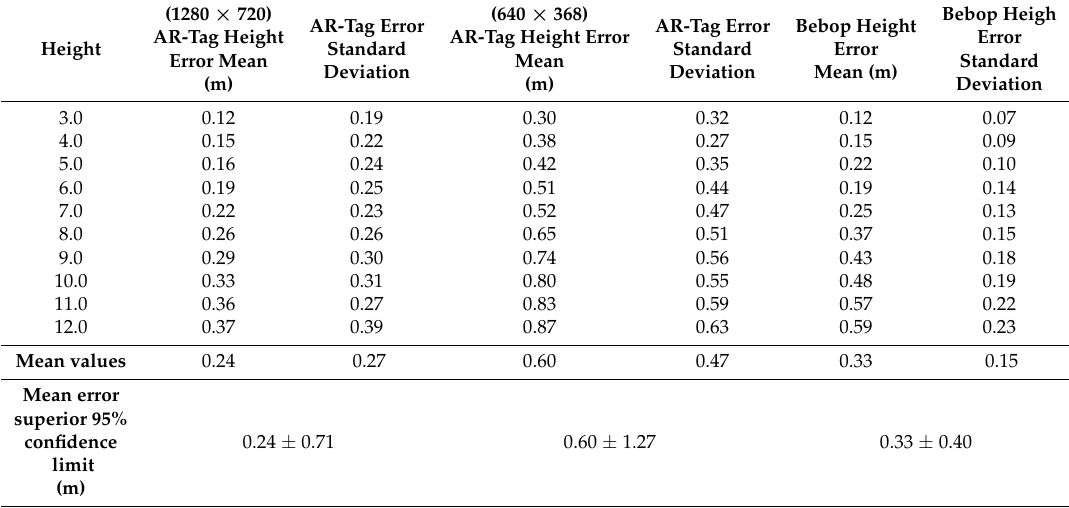
Table 6. Absolute error height measurement: AR-Tag × Bebop